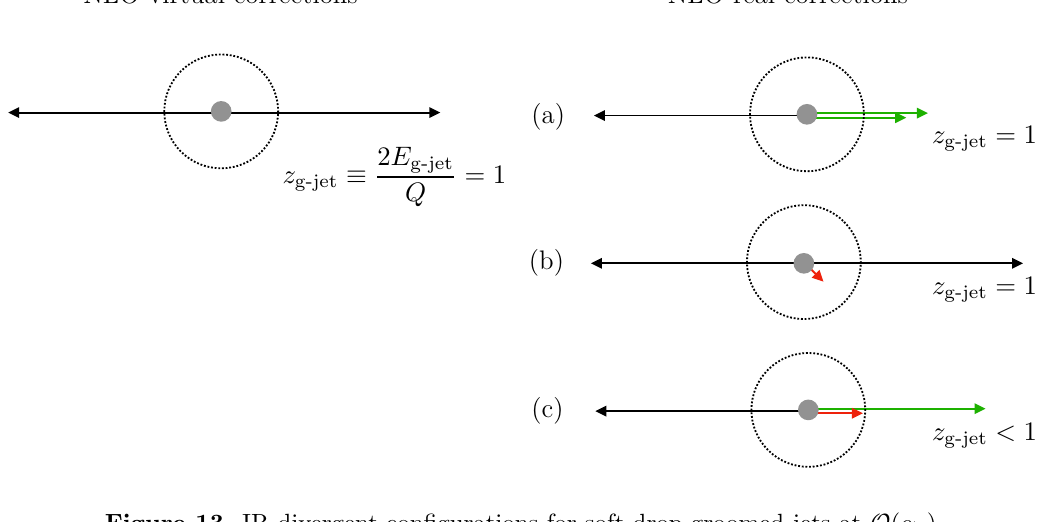
Figure 13 . IR divergent con(cid:12)gurations for soft-drop groomed jets at O ( (cid:11) s